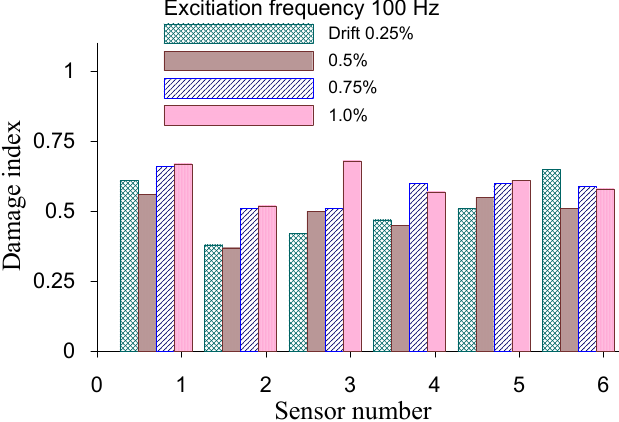
Appl. Sci. 2019 , 9 , x FOR PEER REVIEW Figure 15. Damage index at each drift ratio for RCW2 (excitation frequency 100 Hz).